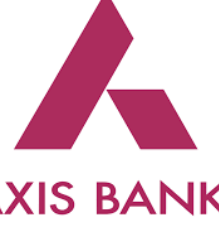
Figure 7. Example: Axis Bank logo.